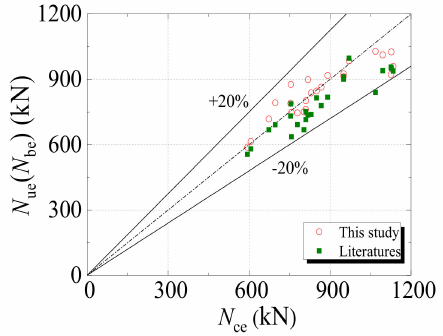
Figure 8. Comparisons between experimental and simulation results.